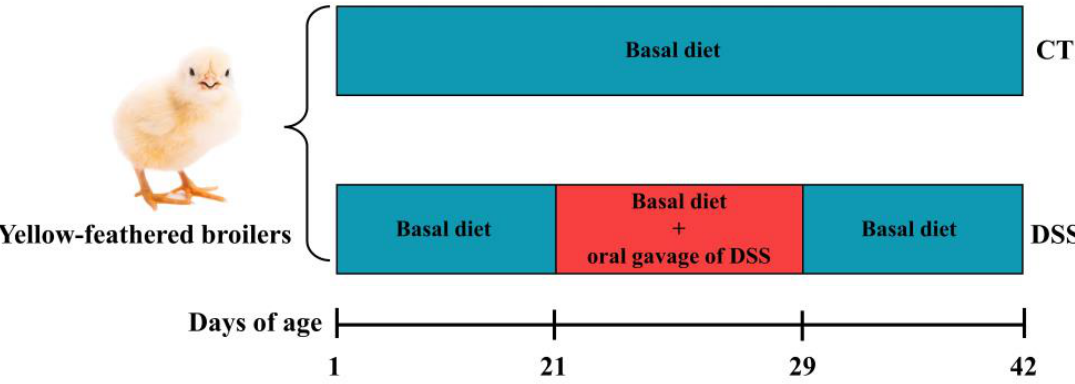
Figure 1. Experimental scheme of DSS-induced enteric inflammation in